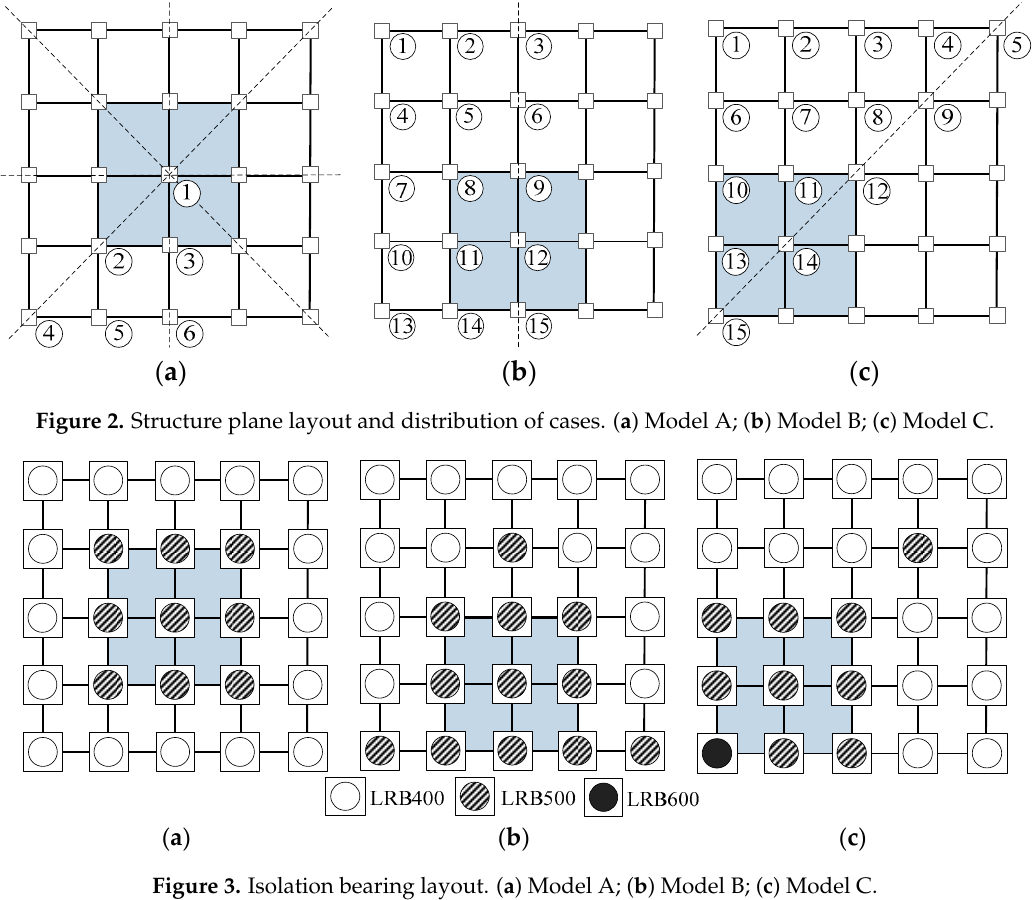
Figure 1. The 3D plots of structures. ( a ) Model A; ( b ) Model B; ( c ) Model C.